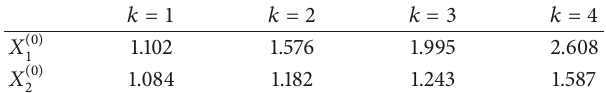
Table 1: The data